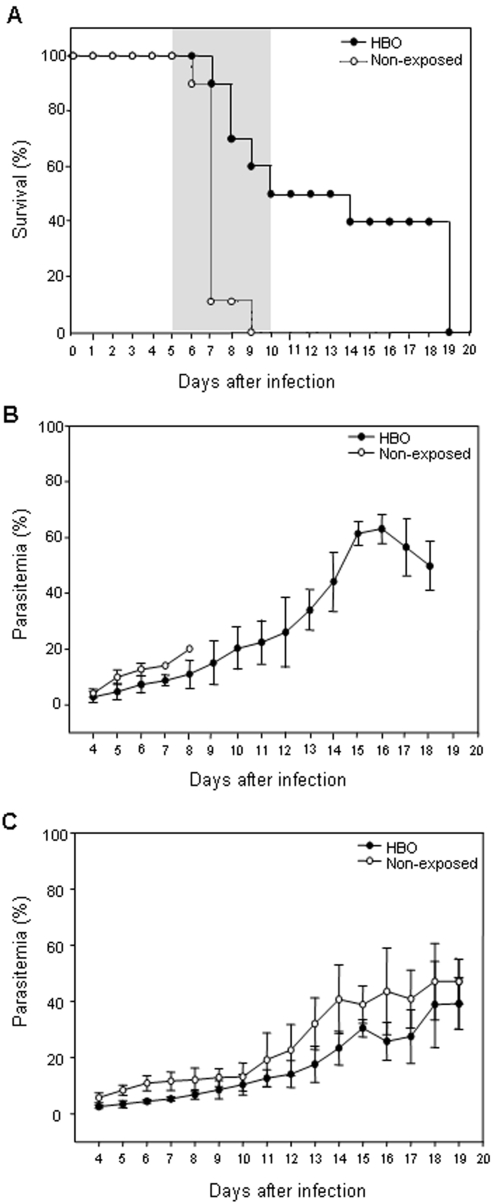
HBO's effect on the survival and the parasite development in P. berghei-infected mice.(A) Groups of 10 mice infected i.p. with 106 iRBC were exposed or not to HBO (100% O2, 3.0 ATA) for 1 h from day 0 to 10. Pressurized oxygen significantly protected mice against CM neurological symptoms (P<0.0005). Neurological signs of CM appeared on days 5–10 with death occurring approximately 24 h after onset (shaded area). Parasitemia levels were assessed daily in mice infected with (B) P. berghei ANKA (PbA; cerebral line) or (C) P. berghei NK-65 (PbNK-65; non-cerebral line) regardless of exposure to HBO. HBO significantly (P<0.05) reduced the parasite burden on days 4–6 and 4–13 p.i., respectively in PbA- and PbNK-65-infected mice when compared to non-exposed animals.